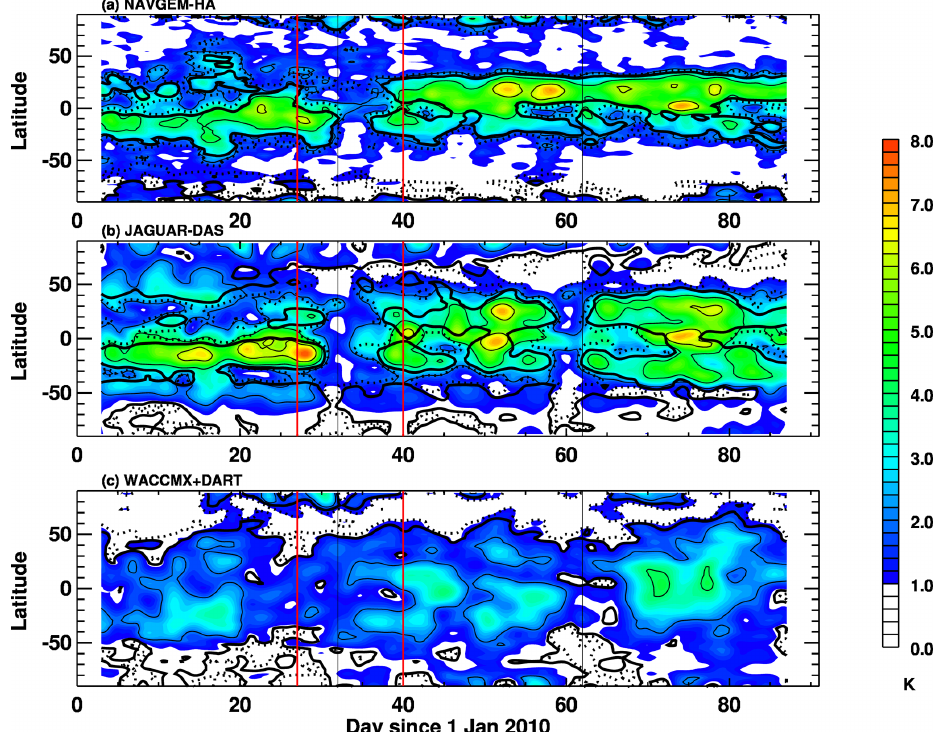
Figure 20. As in Fig. 18 but for the nonmigrating diurnal wave 3 (DE3).